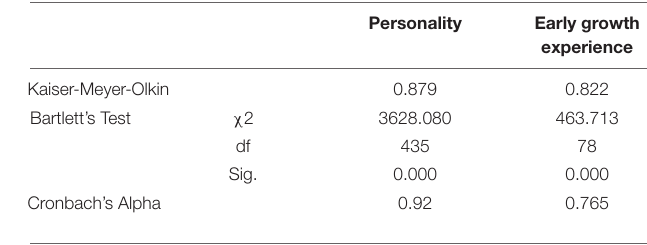
TABLE 4 | Model fit